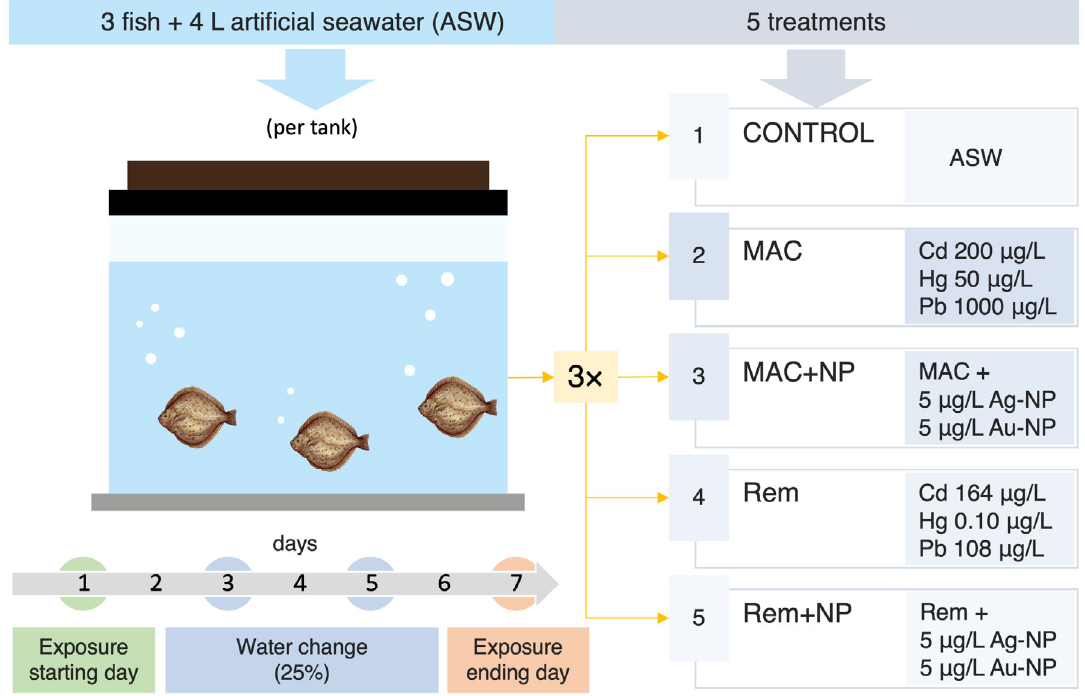
Figure 1. Schematic representation of the experimental design, treatments, and concentrations.